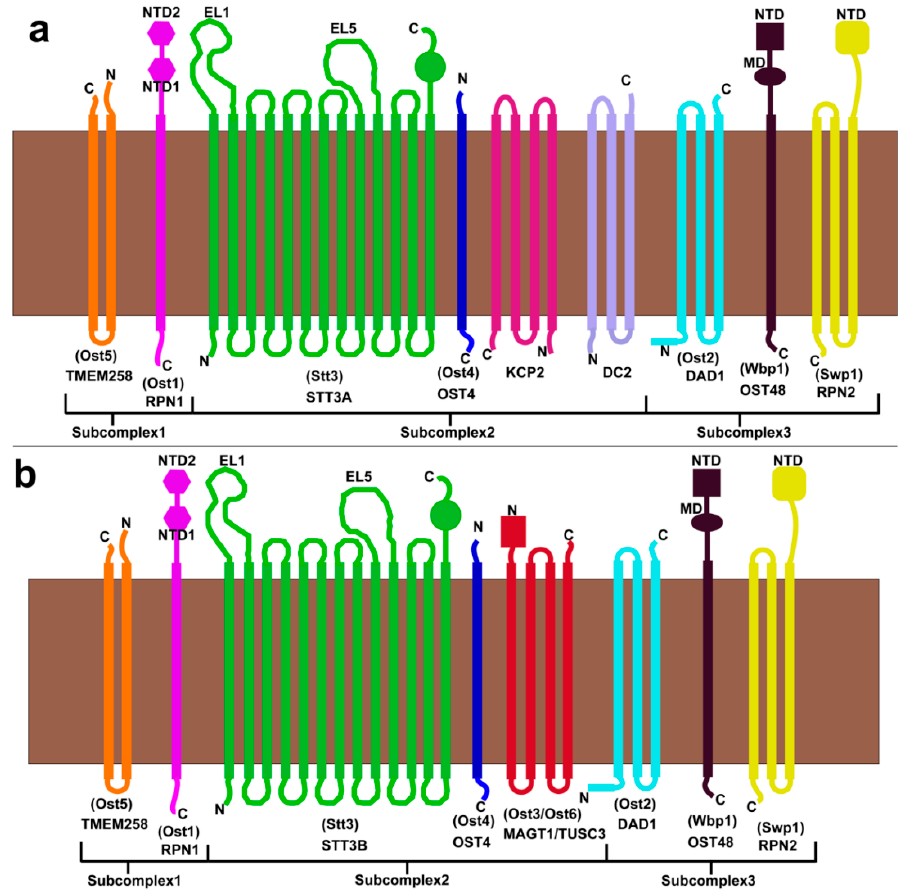
Figure 7. Subunit organization of the metazoan and yeast OST complex in ER membrane. ( a ) OST-A complex. ( b ) OST-B complex. Subunits are labeled by mammalian names with yeast subunit names shown in parentheses. Mammalian OST-A complex is homologous to the yeast OST complex, while the yeast OST lacks KCP2 and DC2 subunits found exclusively in the OST-B complex.